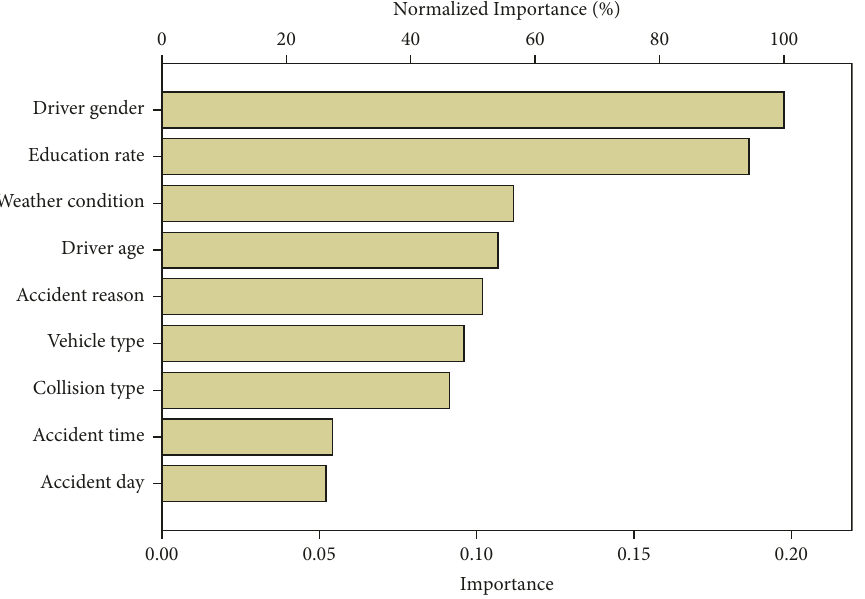
Figure 13: Independent variable importance chart in the RBF